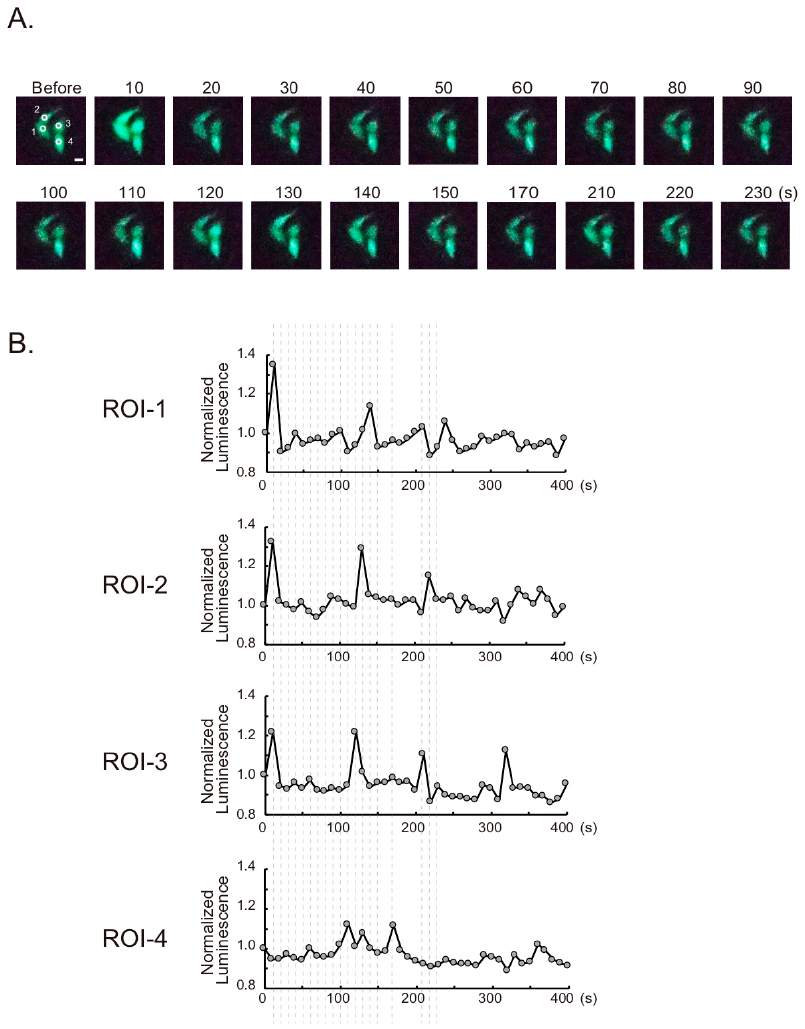
Figure 3. Ca 2 + imaging with GeNL(Ca 2 + )_520 in HeLa cells based on the smartphone microscope. ( A ) Time-lapse bioluminescence images of GeNL(Ca 2 + )_520 in cytosol. Cells were stimulated by histamine. The numbers indicate the elapsed time after stimulation. Scale bar, 20 µ m. ( B ) Time-course variations of bioluminescence intensity in cells. Regions of interest (ROIs) for the measurement are shown as white circles in A. The x -axis shows the elapsed time after the stimulation (at 0). Broken lines indicate the time points of selected images in